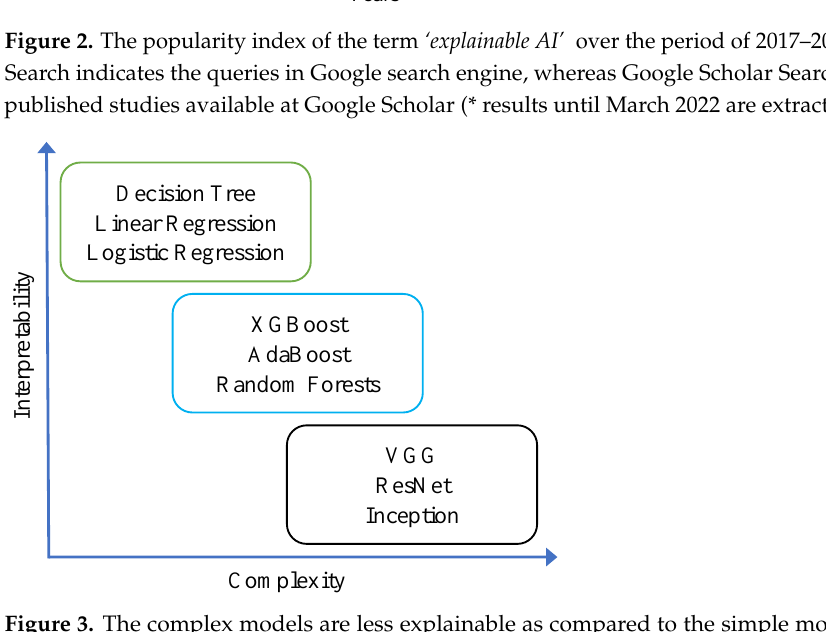
Figure 3. The complex models are less explainable as compared to the simple models, because of the increasing number of hidden layers and parameters. The more simple a model is, the more interpretable it